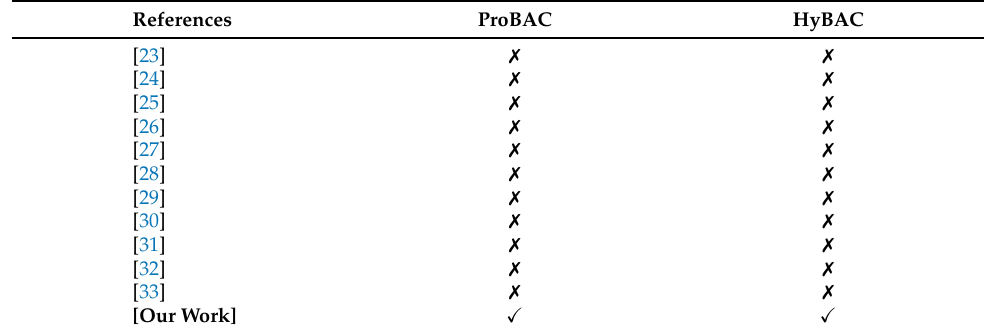
Table 1. Previous reviews on IoT access control and their comparison with our